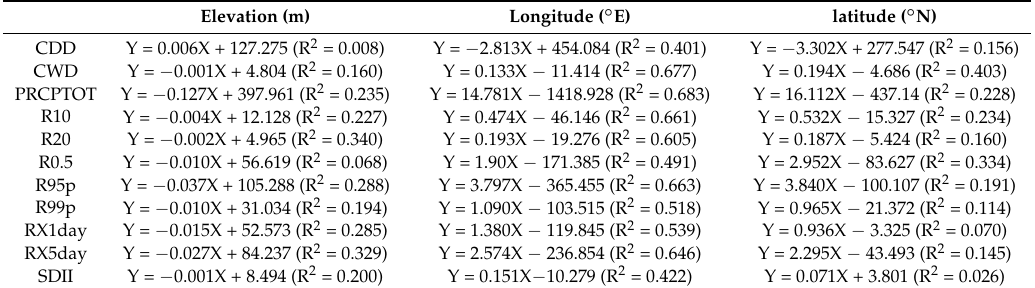
Table 2. Correlation between extreme precipitation indices and elevation, longitude, and